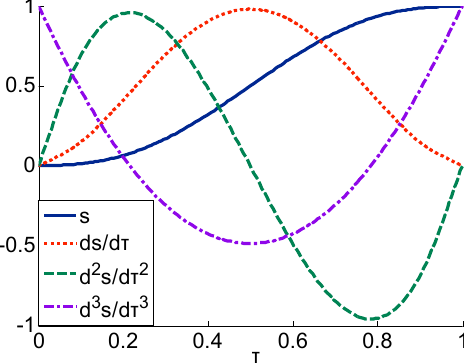
Figure 5. Angular velocity in gap stage.